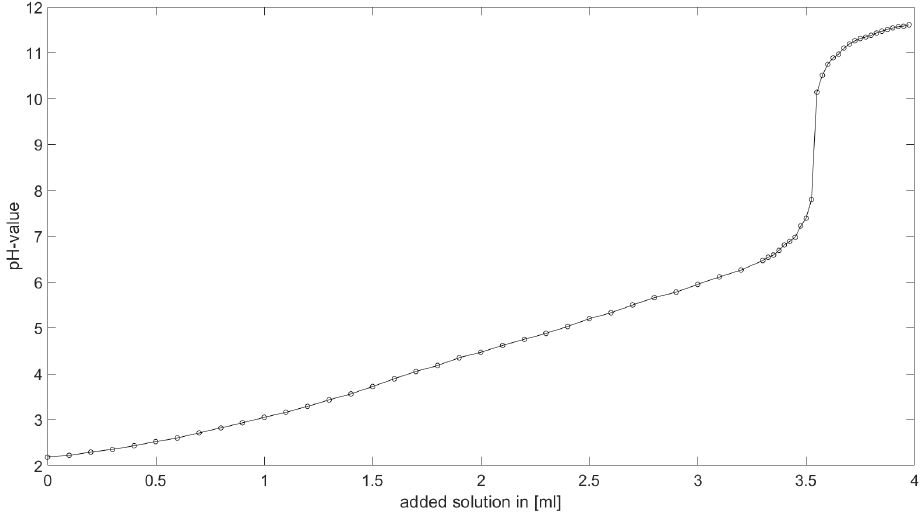
Figure 8. Experimentally determined titration curve for citric acid.